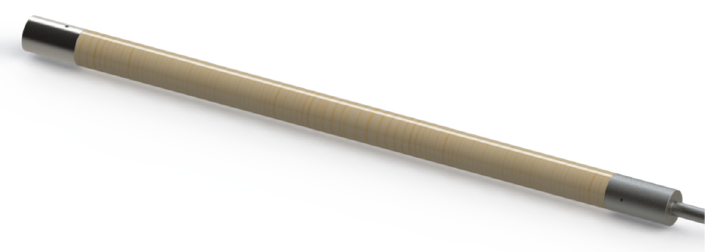
Figure 16. Traction roller.